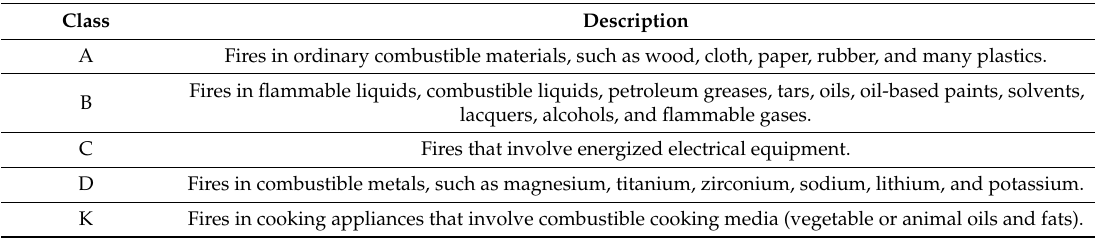
Table 3. Classification of fires